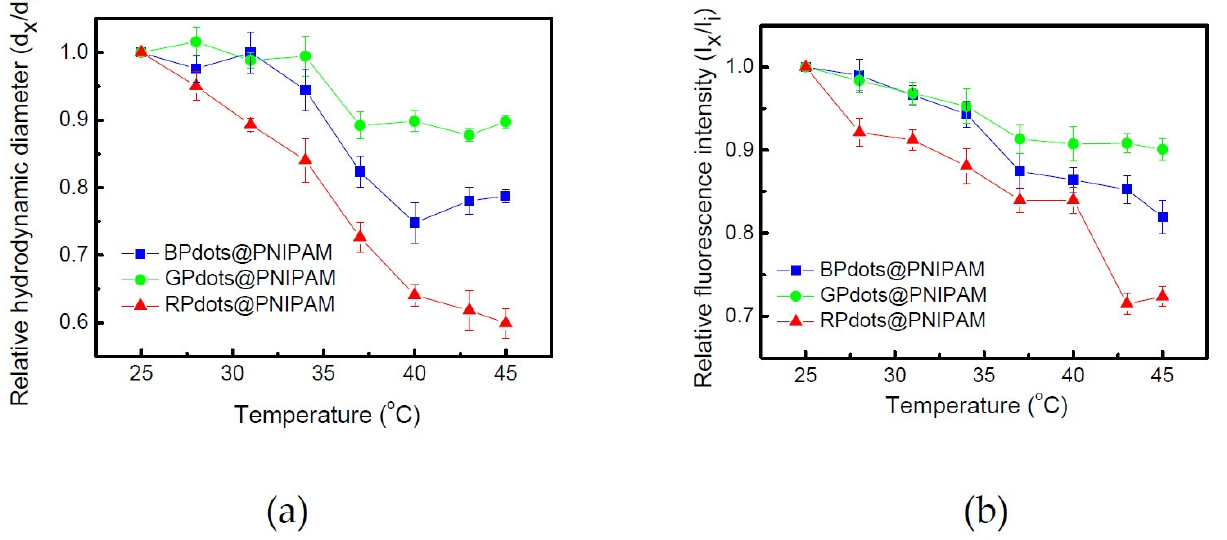
Figure 3. ( a ) UV-vis and ( b ) fluorescence spectra of BPdots@PNIPAM ( ■ ), GPdots@PNAIPAM ( ● ), and RPdots@PNAI- PAM ( ▲ ) in water at 25 °C. Excitation wavelength 350 nm.